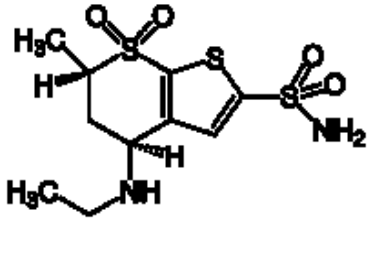
Figure 1. Chemical Structure of Dorzolamide